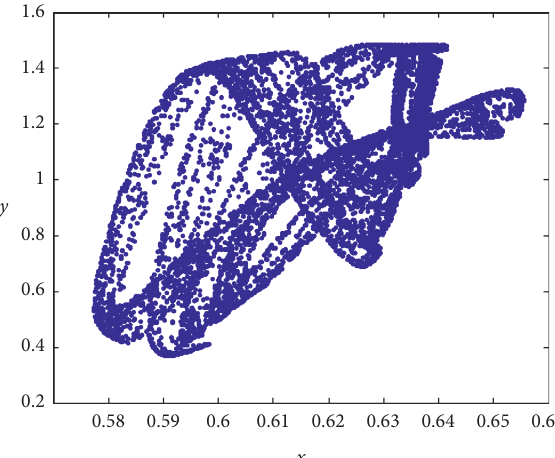
Figure 20: Flip bifurcation diagram versus parameters c when a � 1, b � 1.14, c � 2.93, d � 1.3, e � 0.21, f � 0.1, g � 0.35, h � 2, α � 0.05, and β � 2.